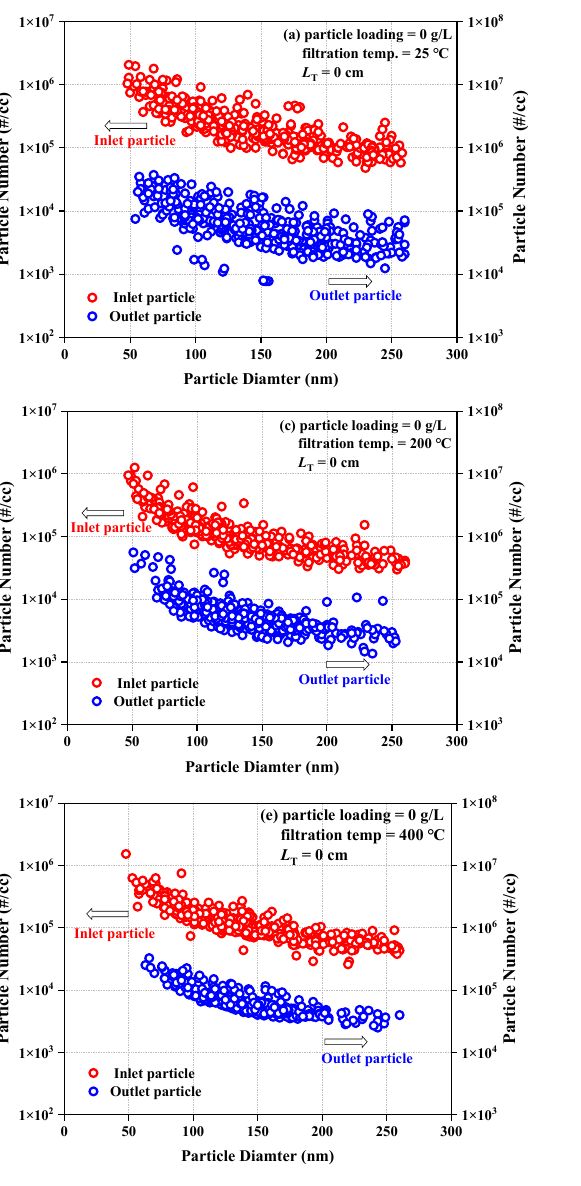
Figure 5. The particle number of inlet and outlet particle with particle loading of 0 g/L, transition section length L T of 0 cm under different filtration temperatures: ( a ) 25 ◦ C; ( b ) 100 ◦ C; ( c ) 200 ◦ C; ( d ) 300 ◦ C; ( e ) 400 ◦ C; ( f ) size distribution probability of particle diameter in DPF inlet and outlet.